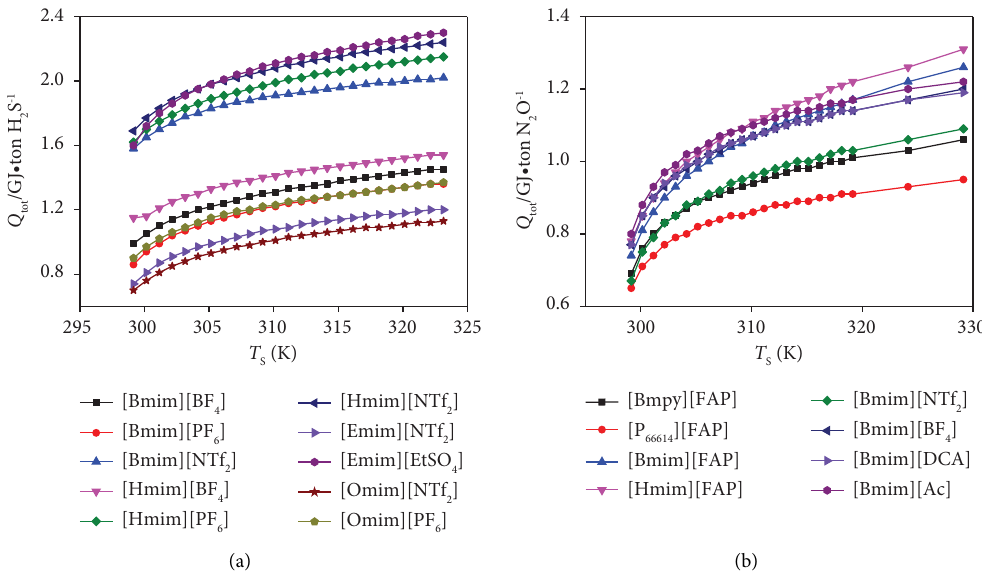
Figure 8: Te energy consumption of (a) 10 physical absorbents for high-sulfur natural gas and (b) 8 physical absorbents for adipic acid of-